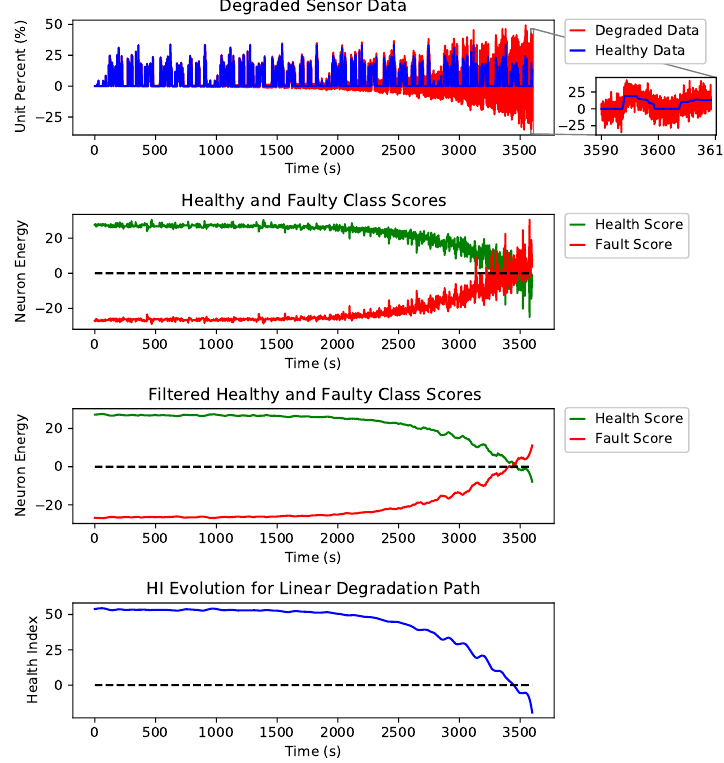
Figure 9. Steps taken to construct the health index (HI) from an exponentially degraded AccP data